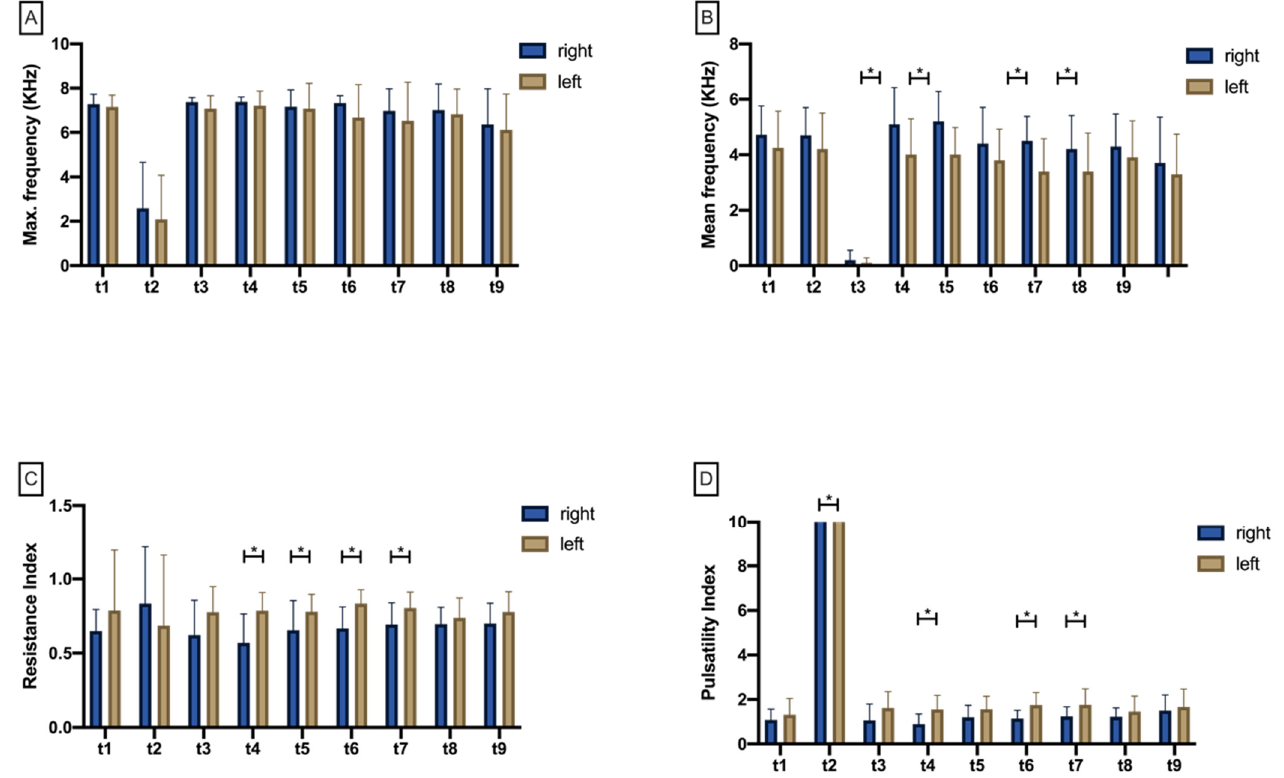
Figure 5. Bar chart with means ( ± SD) showing Max.KHz ( A ), Mean.KHz ( B ), resistance index ( C ), and pulsatility index ( D ) at different measurement timepoints (t1–t9). Crossbars with asterisks mark significant differences.